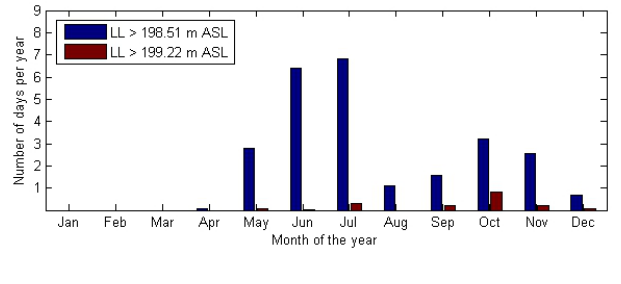
Fig. 3. Number of days per month of the year when lake levels were higher than 198.51 m ASL (corresponding to the lowest point of Piazza Cavour; Comerci et al. 2007) and 199.22 m ASL (corresponding to significant floods with more than 1.5 ha of the city flooded; Gastine 2006, unpublished thesis), averaged over the period